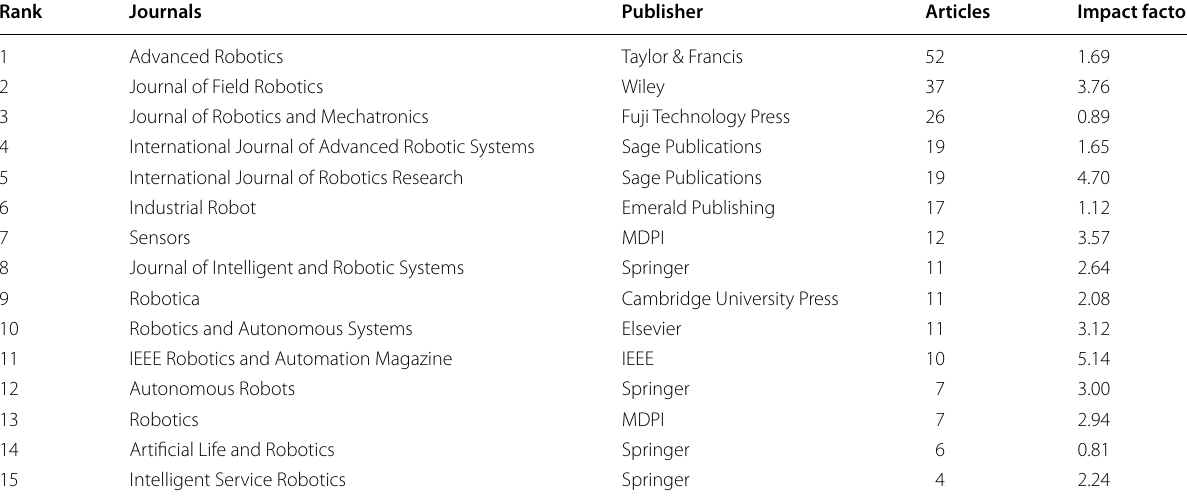
Table 5 Top 15 journals published research articles related to RR